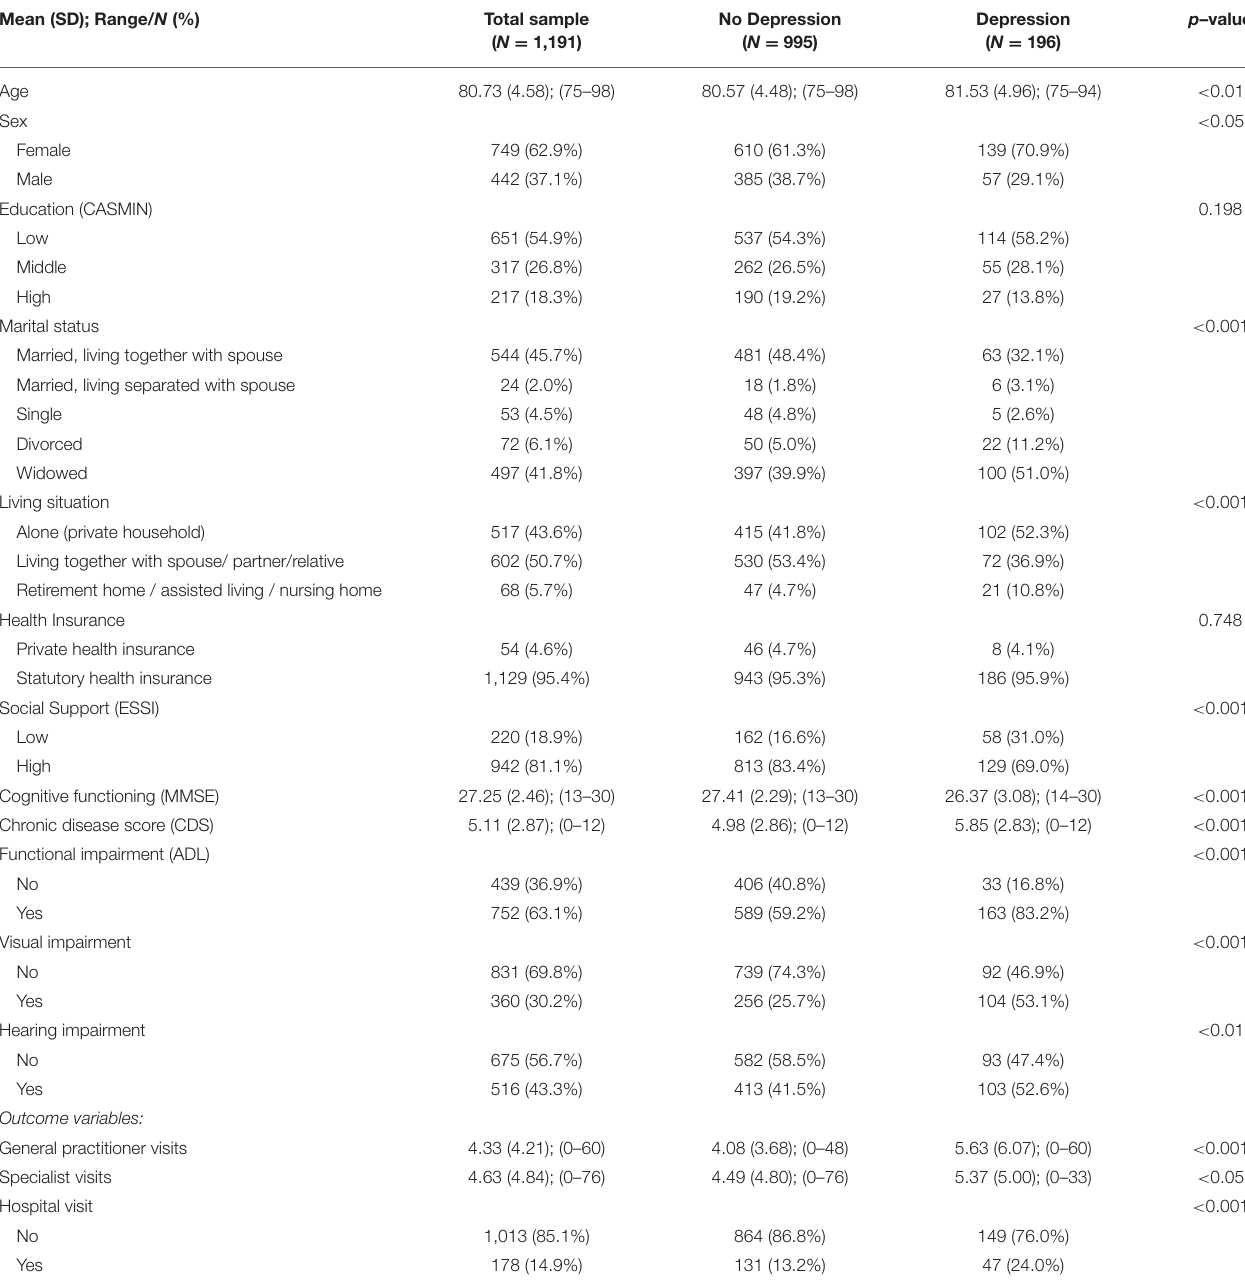
TABLE 1 | Descriptive characteristics of study cohort at baseline—total sample, depressive (GDS ≥ 6) and non-depressed individuals. Mean (SD); Range/ N